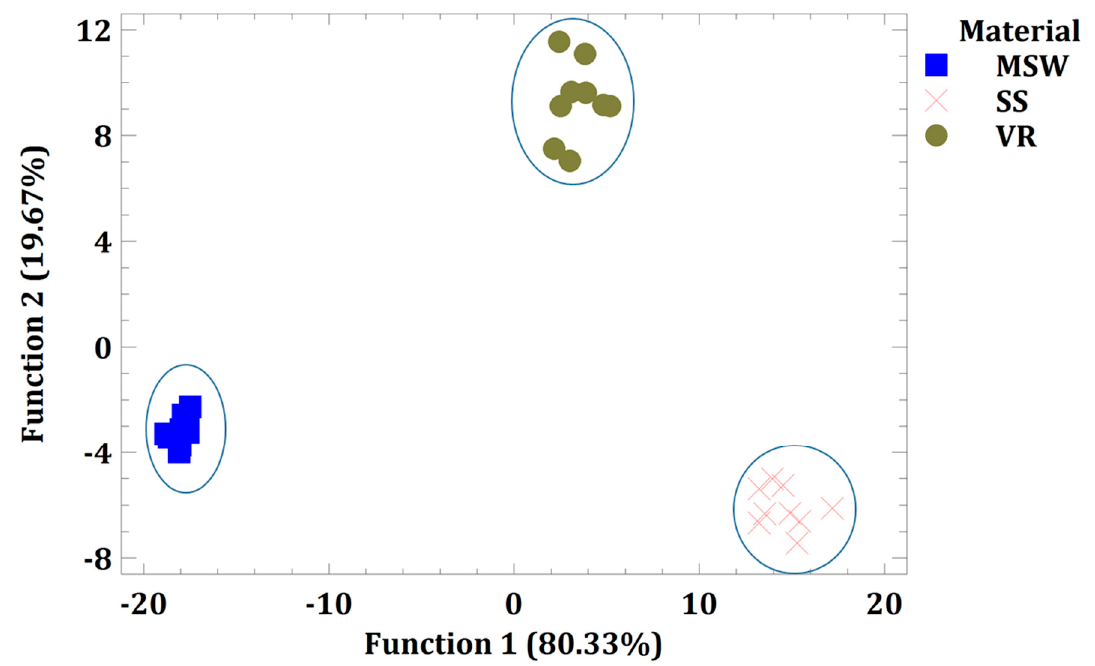
Figure 4. Discriminant analysis from municipal solid waste (MSW), sewage sludge (SS) and vegetal residue (VR).